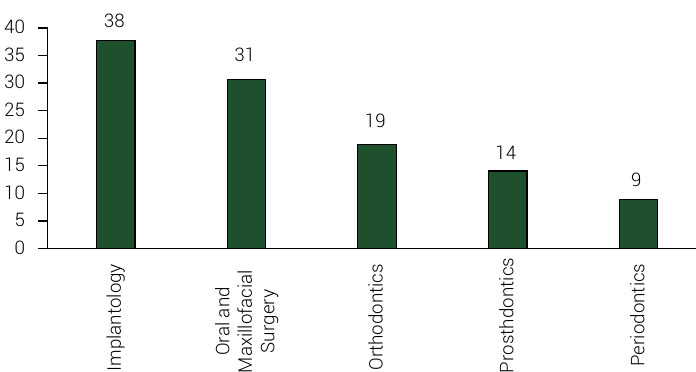
Figure 3. Dentists’ specialties in lawsuits against dentists involving the questioning of dental treatments, 2012-2017, São Paulo, SP, Brazil.